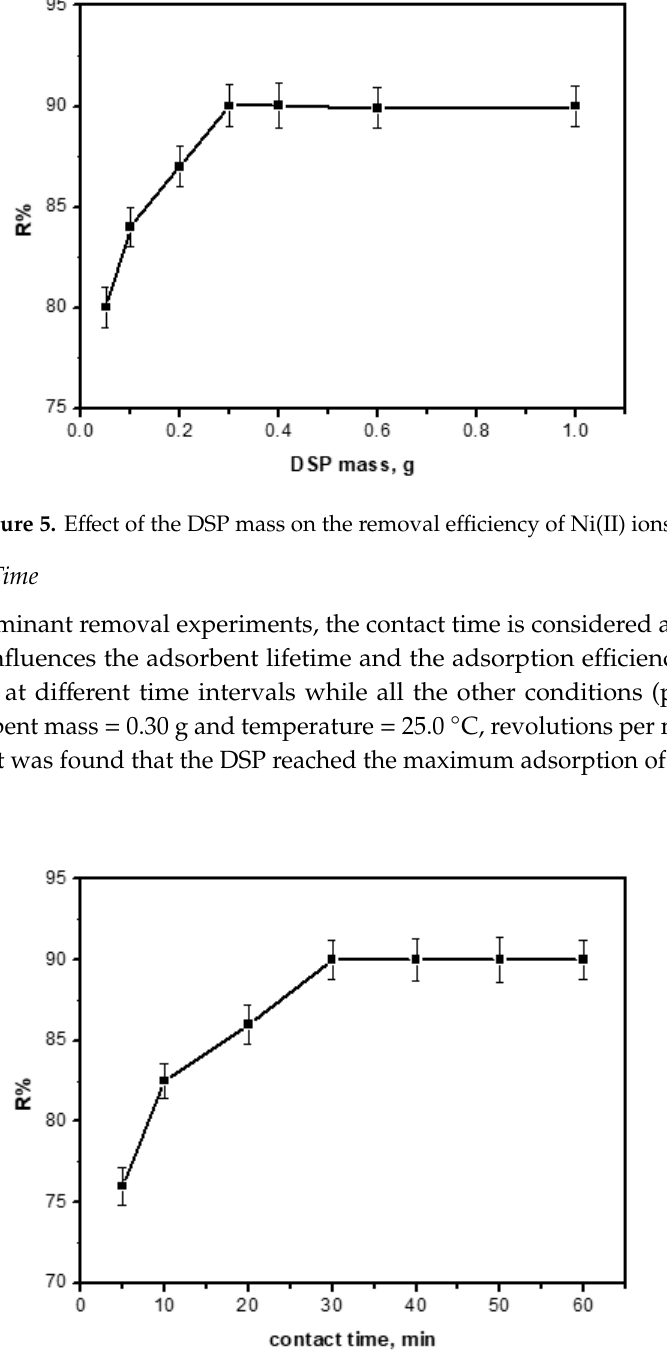
Figure 4. Effect of particle size of the DSP on the efficiency of removal of Ni(II) ions.